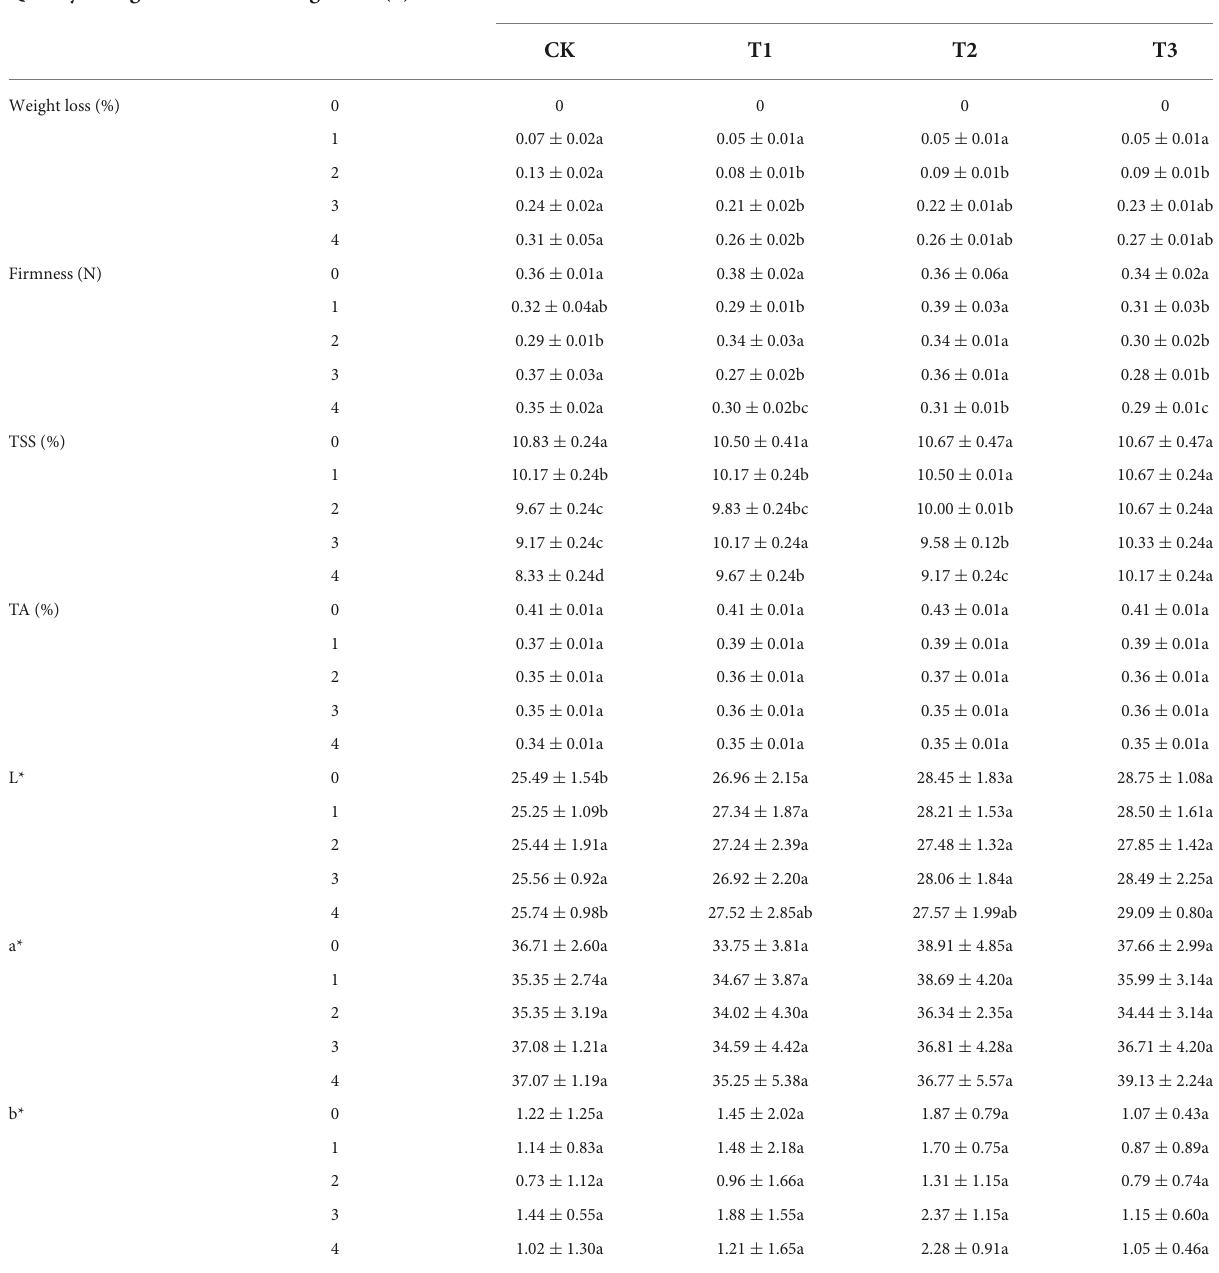
TABLE 2 Effect of ozone treatment on weight loss, firmness, total soluble solids, titratable acid content, L* , a* , and b* of fresh-cut pitaya during storage. Quality